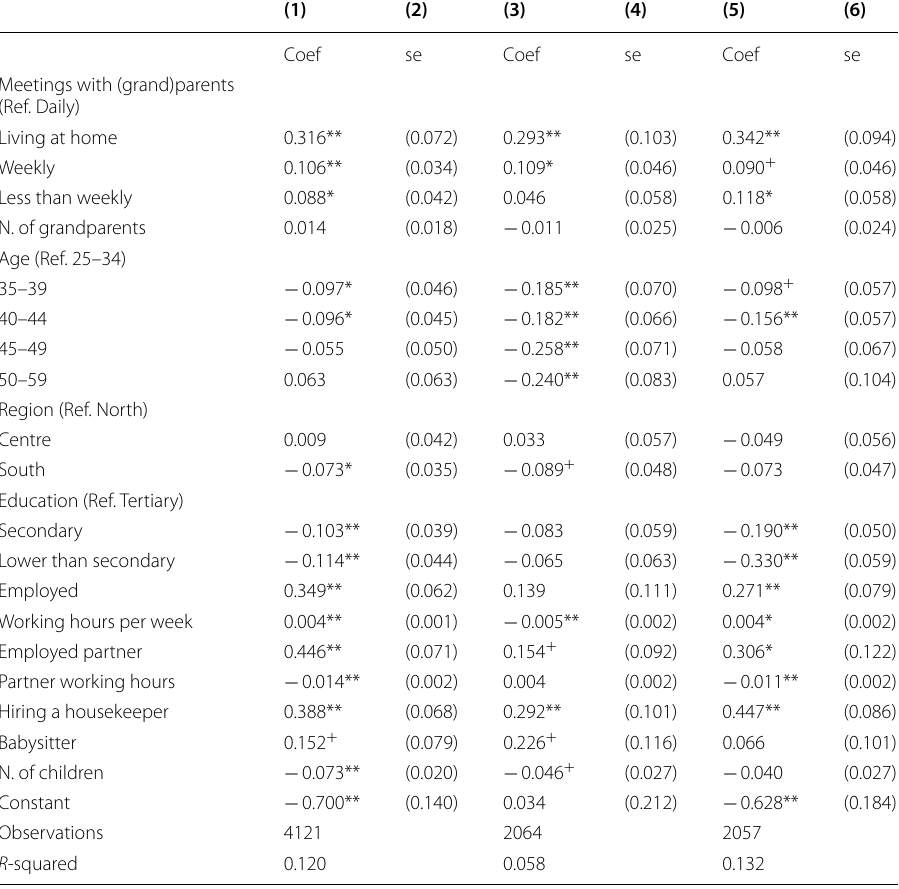
Table 10 Linear regression models on symmetry in the division of routine and instrumental housework tasks (5 items) ( Z